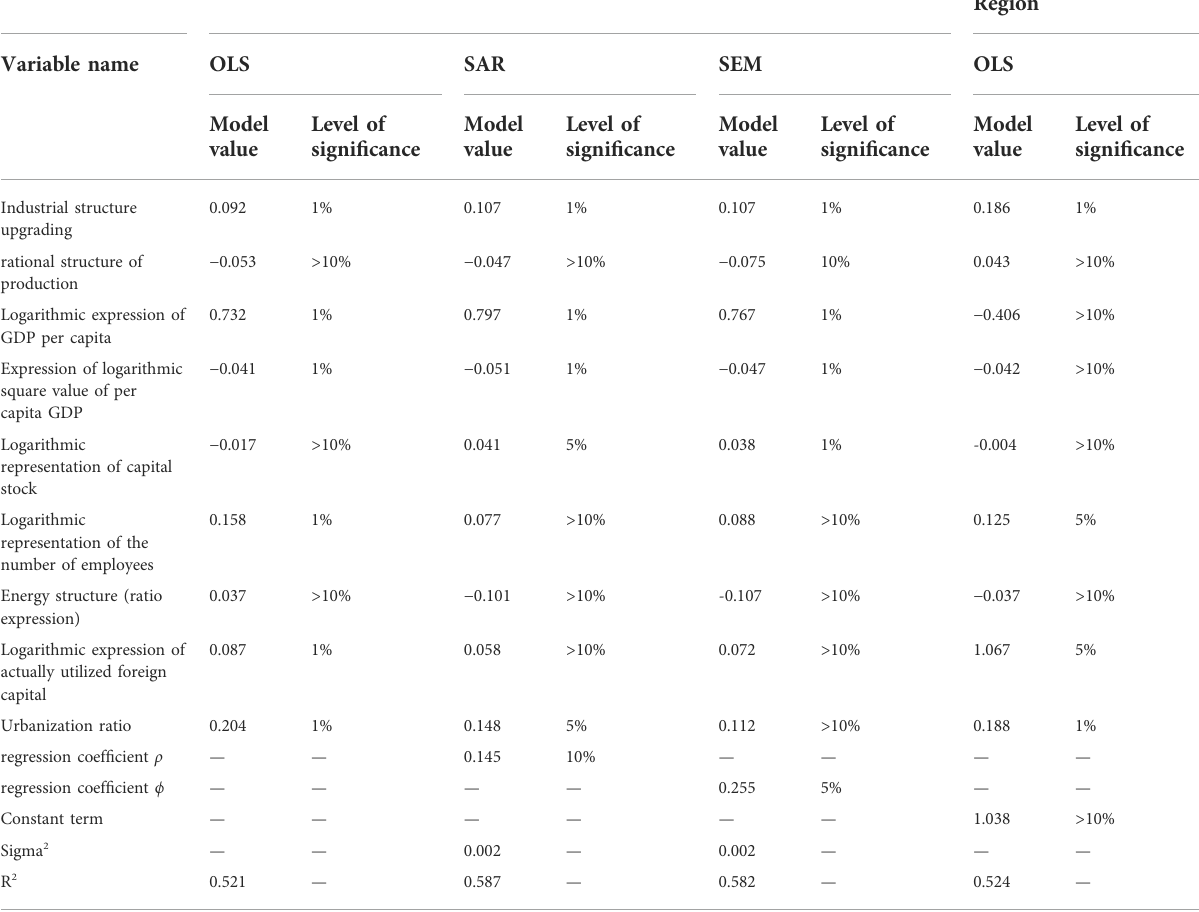
TABLE 5 Empirical results of yangtze river delta region and chengdu chongqing region.